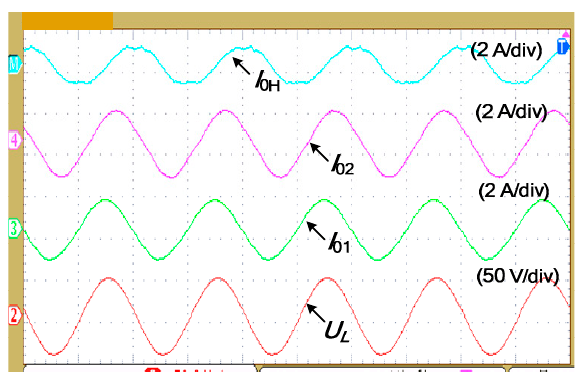
Figure 9. Steady state experimental waveforms using the conventional method.